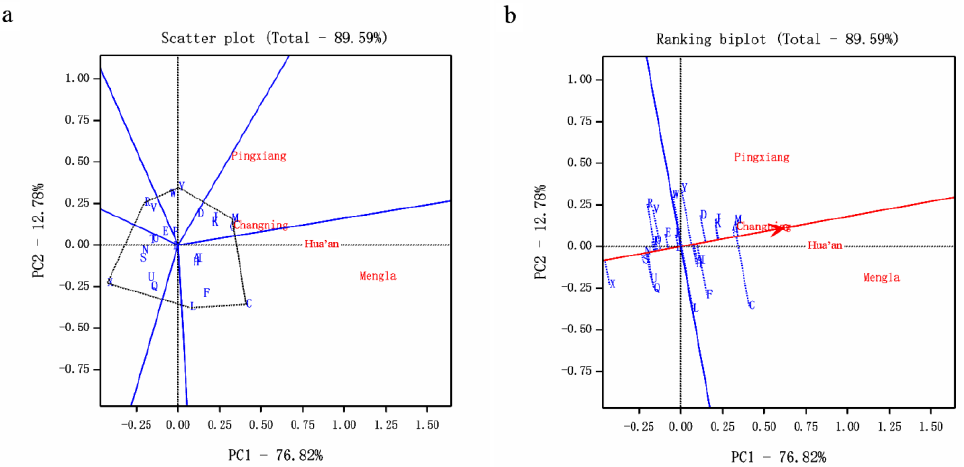
Figure 3. Biplot analysis based on HCB data of 25 provenances. ( a ) Polygon view of GGE biplot—which is best for what, ( b ) genotypes of ranking provenances. A, Mengla; B, Yuanyang; C, Mojiang;